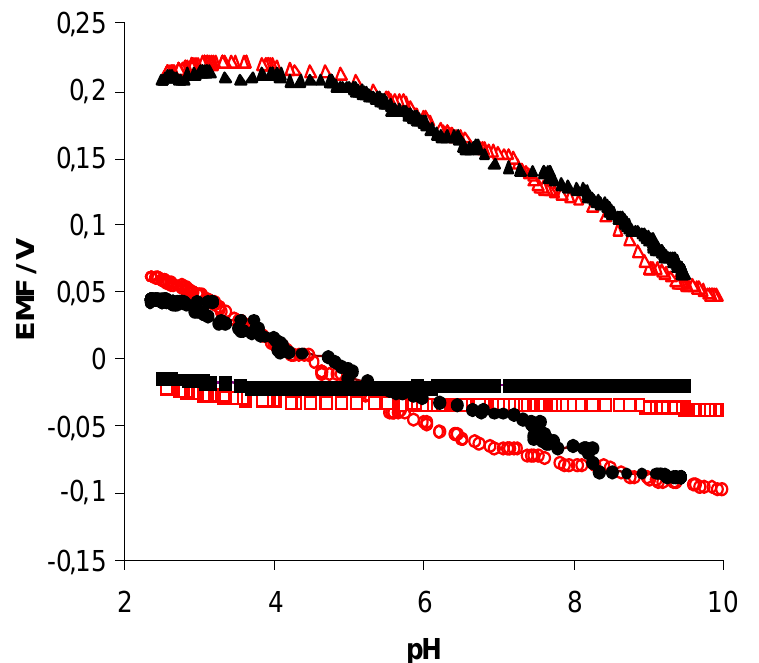
Figure 2 . Potential vs pH curves obtained by electrodes containing: ( o ) ligand; □ ( ∆ ) ligand + 50% TDDMACl; ( ) ligand + 50% K-TpClPB ( pH was changed from 9.5 to 2.5); ● ( ) ligand; ( ▲ ) ligand + 50% TDDMACl; ( ■ ) ligand + 50% K-TpClPB ( pH was changed from